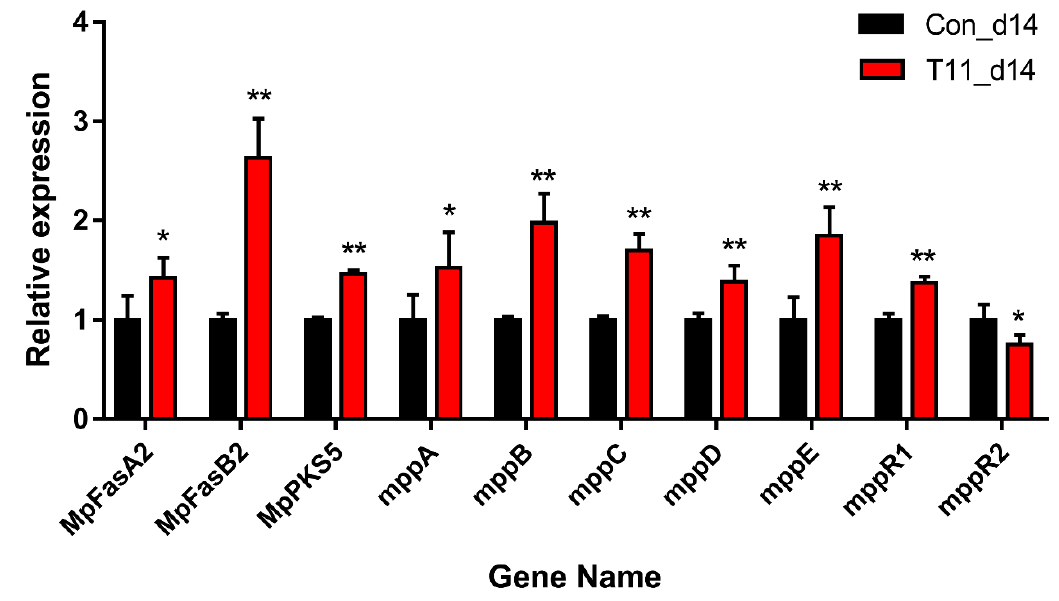
Figure 8. Relative expression levels of MPs-biosynthesis-related genes in Con group and T11 group on 14th day based on RT-qPCR. The transcriptional levels were normalized to β -actin gene. Note: * p < 0.05 and ** p < 0.01 versus the Con group.